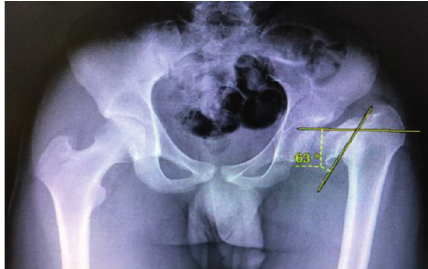
Figure 2: AP radiograph of the pelvis showing pseudoarthrosis of femur neck fracture with significant varus deformity: neck-shaft angle, 75 degree; Pauwels type 3, 63